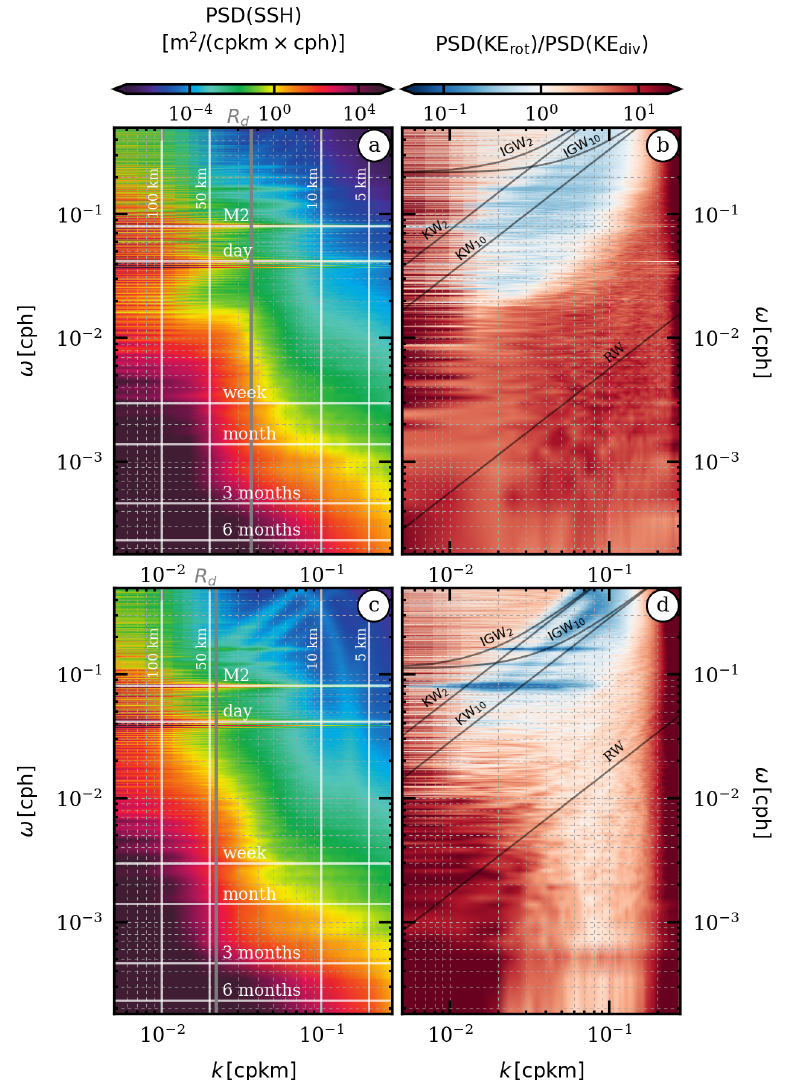
Figure 4. Power Spectrum Densities (PSD) of Sea Surface Height (SSH) computed ( a ) in the Gulf of Oman and ( c ) in the Gulf of Aden. The deformation radii (in gray) and benchmark wavelengths (in white) are indicated in vertical solid lines. Benchmark periods are indicated in horizontal white lines. Ratio of the PSD of the kinetic energy of the rotational part of the flow over the PSD of the kinetic energy of the divergent part computed ( b ) in the Gulf of Oman, and ( d ) in the Gulf of Aden. Dispersion relations of inertia-gravity waves of the second (IGW 2 ) and the tenth (IGW 10 ) modes of Kelvin Waves of the second (KW 2 ) and the tenth (KW 10 ) modes, and of Rossby Waves (RW), are drawn as solid black